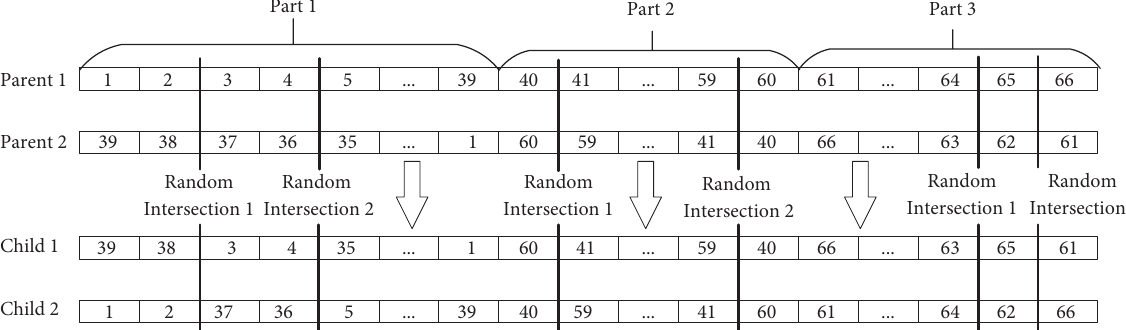
Figure 5: Two-point crossover